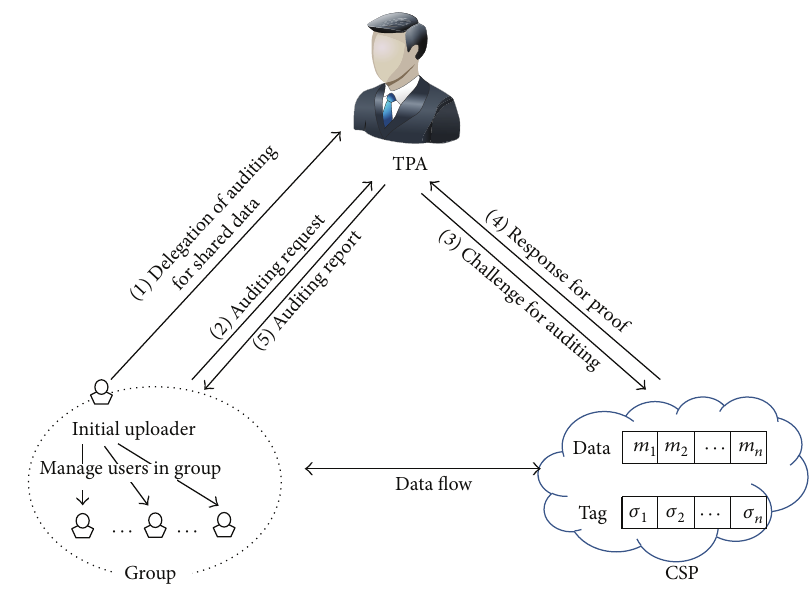
Figure 4: Our system model for auditing mechanism.